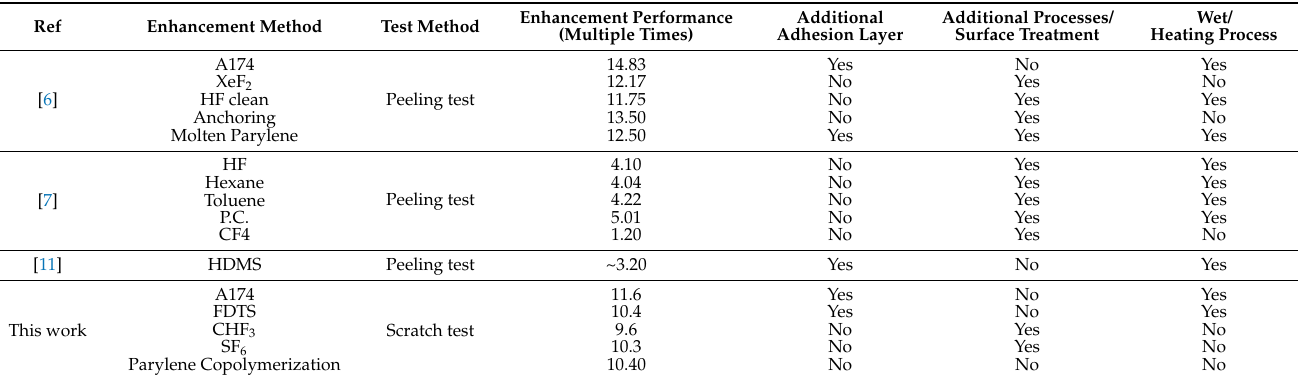
Figure 4. Comparison of the adhesion strength of Parylene-Si by Parylene copolymerization and tradi- tional adhesion enhancement methods. The Parylene copolymer presented comparable enhancement performance to the current methods. Table 3. Comparison of the adhesion enhancement